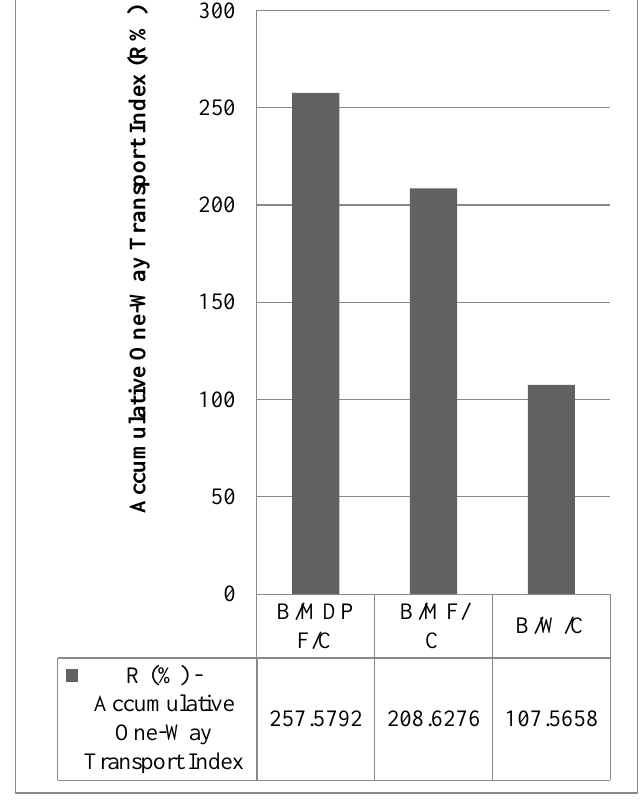
Fig. 5. Accumulative one way transport index of trilayer knitted fabrics